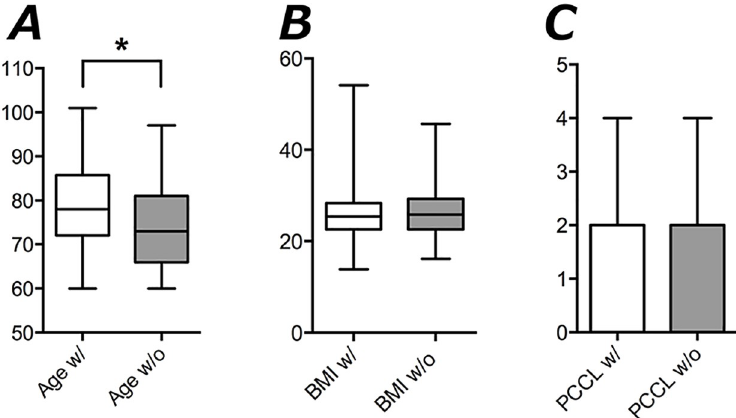
Fig 1. Boxplots (Mean, 25th to 75th percentiles, Min to max) of clinical data in patients with and without prior risk fractures: ( � p < 0.05). (A) Age (B) Body mass index (BMI) (C) Patient Clinical Complexity Level (PCCL).